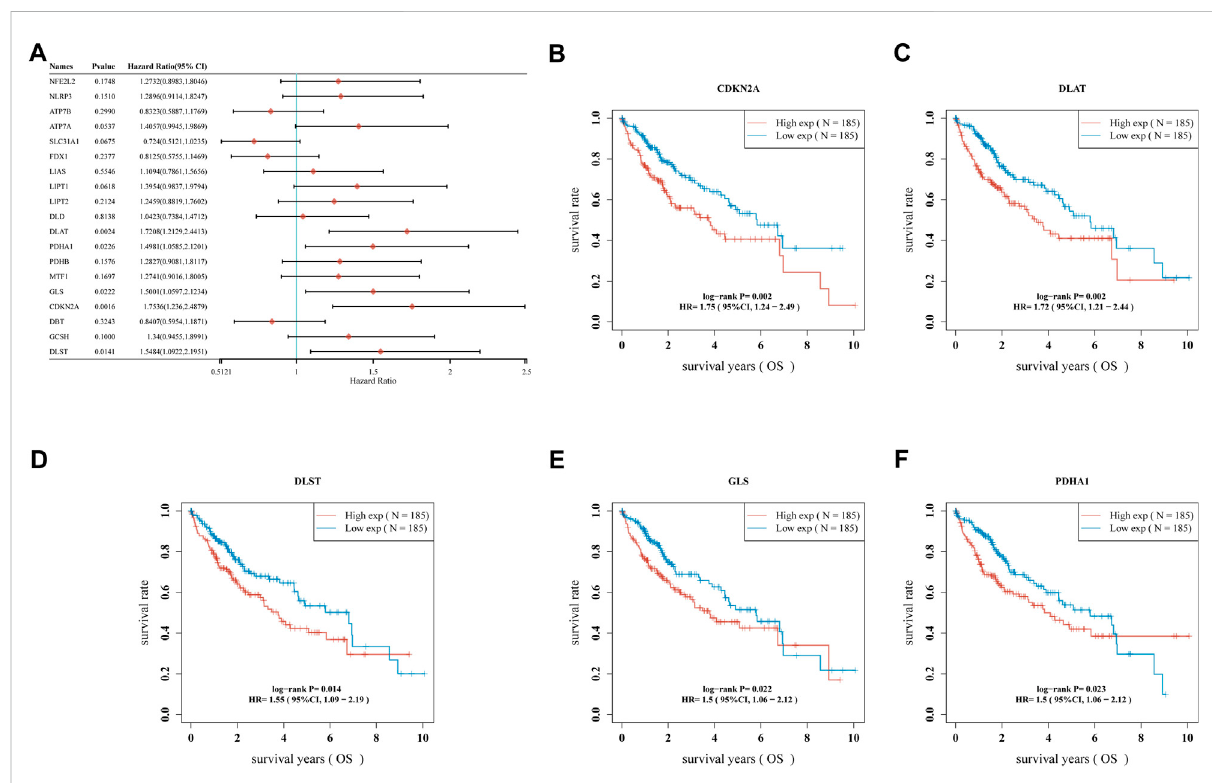
FIGURE 4 The prognostic value of CRGs in HCC. (A) Forest plot showing p-values for the 19 CRGs, (B) CDKN2A, (C) DLAT, (D) DLST, (E) GLS, (F) PDHA1 in HCC patients in the high-/low-expression